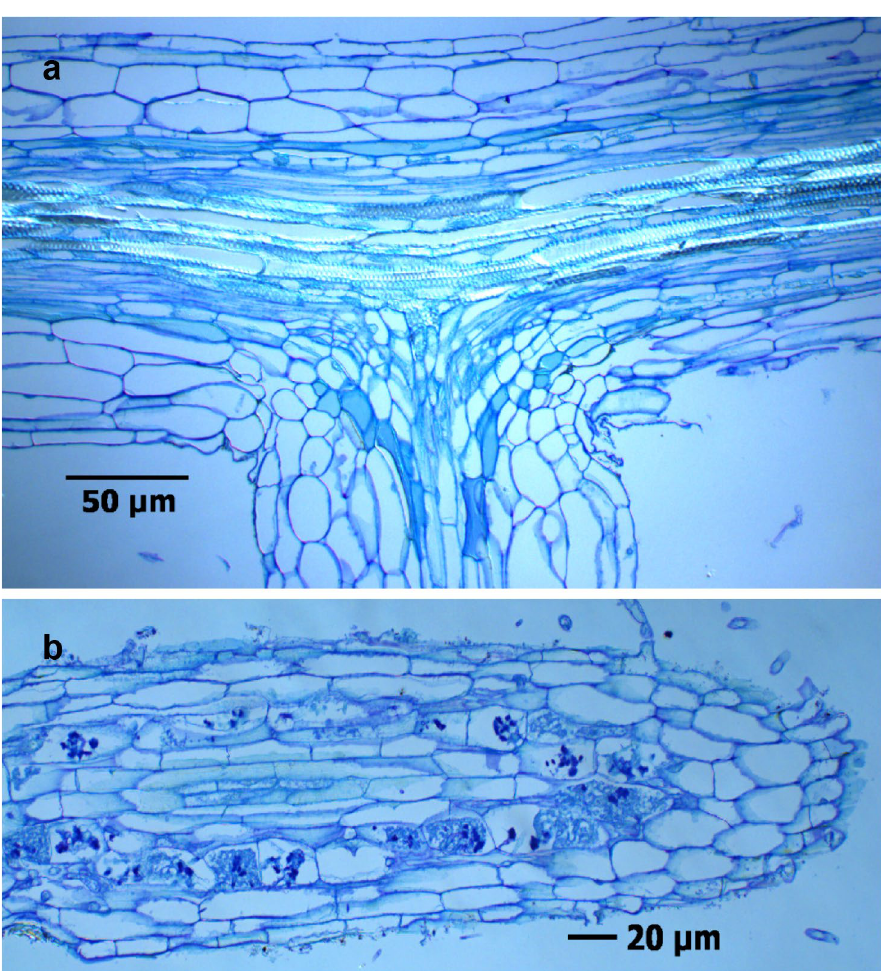
Figure 9. Thin sections of healthy fine root segments of R. corymbifera ‘Laxa’ 9 weeks after start of the biotest. Intact tissue with outgoing lateral root ( a ; treatment H γ) and with mycorrhizal colonization of cortex cells ( b ; treatment H ut).